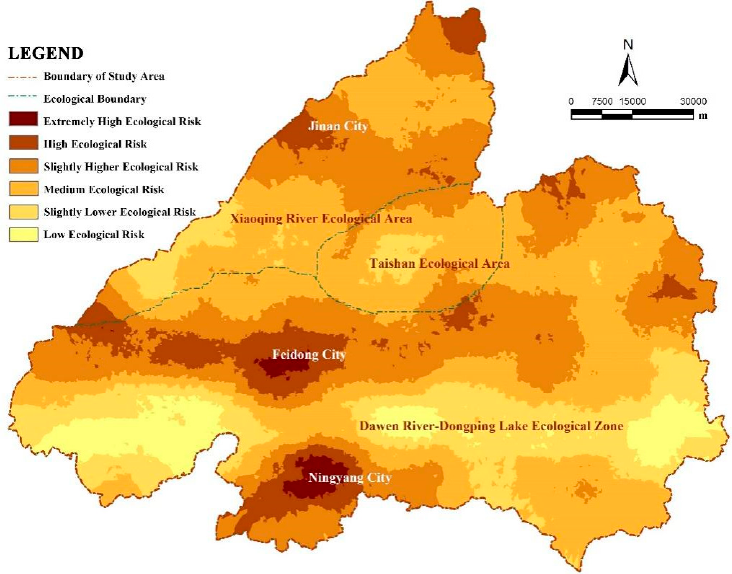
Figure 7. Ecological risk assessment of the life community of mountains–rivers–forests–farmlands– Figure 7. lakes–grasslands.